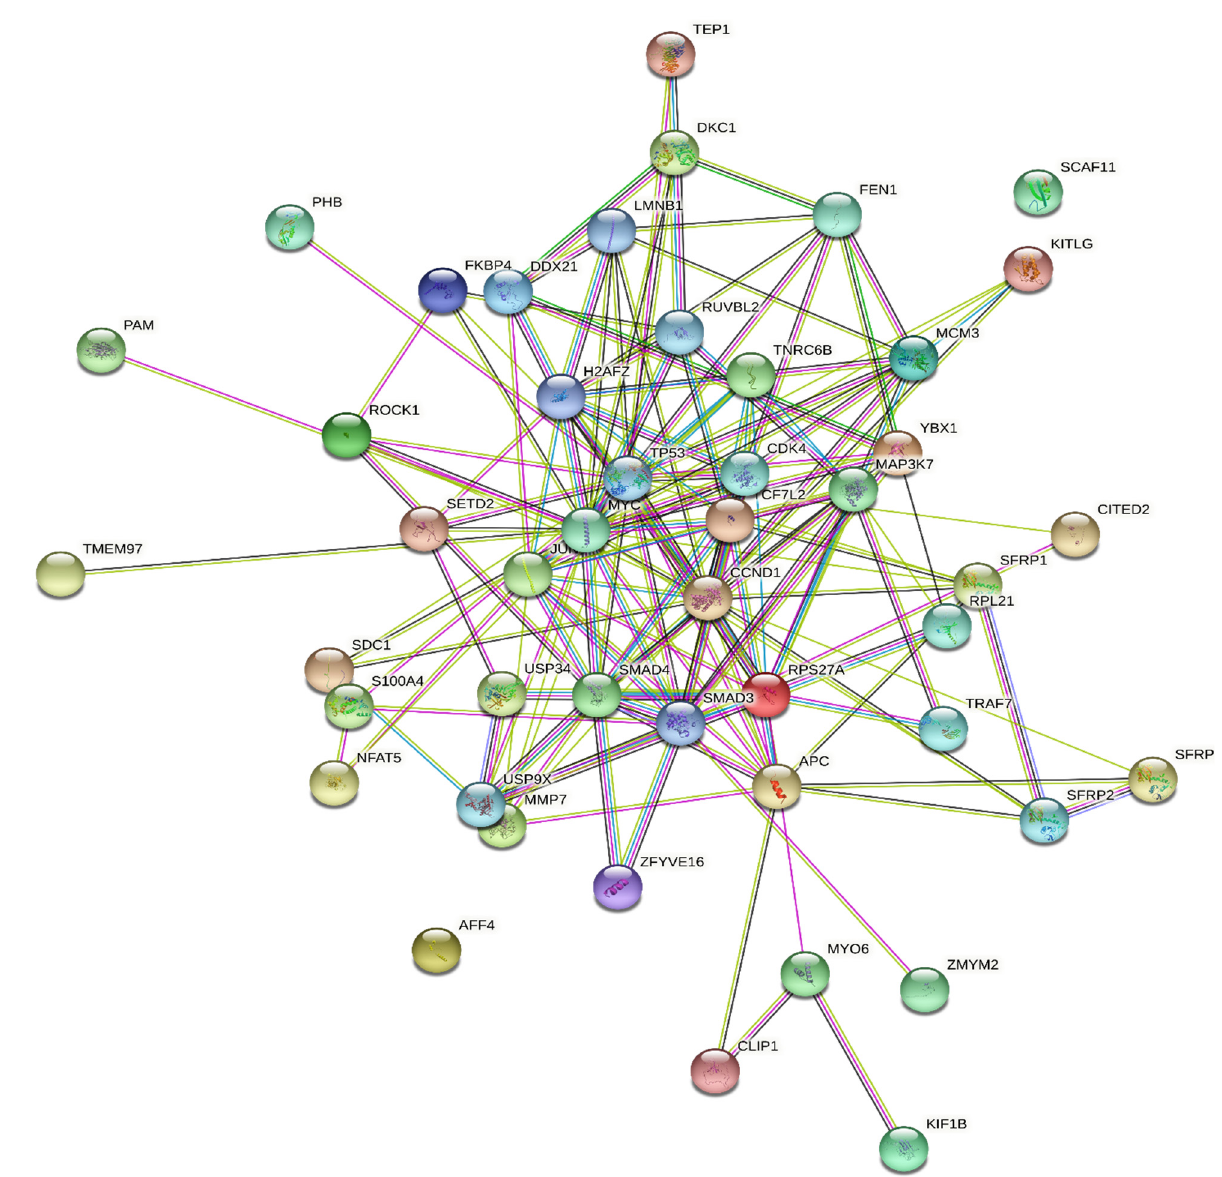
Figure 4. Protein–protein interaction networks. Each node in this protein–protein interaction network represents the single protein-coding gene locus, and the colored nodes are the first shell of interactors. Edges represent the protein–protein associations. The green color between the nodes represents the gene neighborhood.